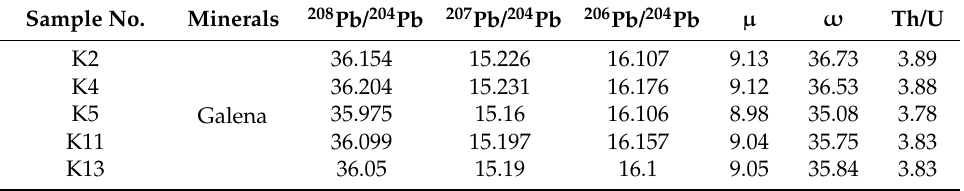
Table 10. Lead isotope compositions of sulfides from the Xiajinbao gold deposit. Sample